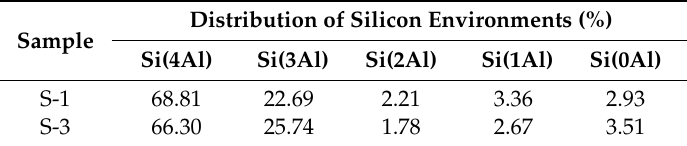
Table 5. The distribution of silicon environments for samples synthesized by different templates.